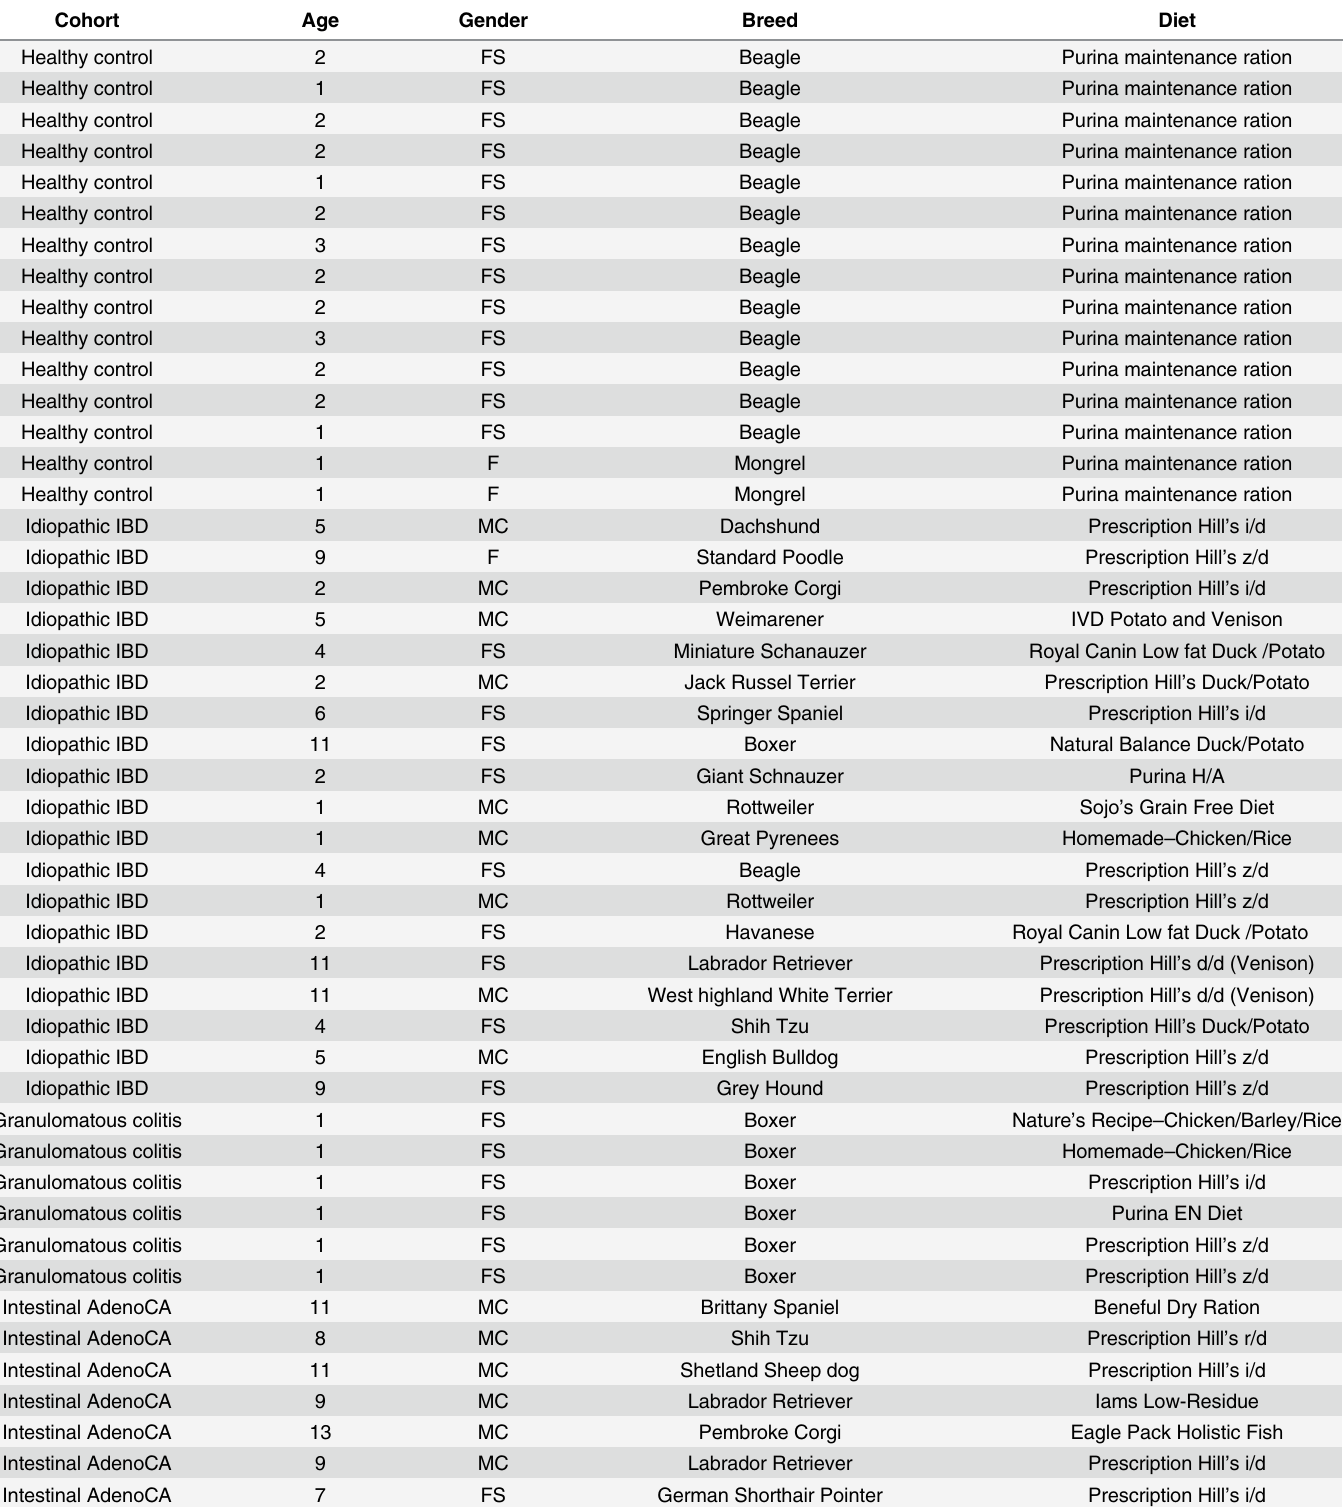
Table 2. Dog cohort demographics. Canine cohort demographics with regards to age, gender, breed, and diet at the time of endoscopic